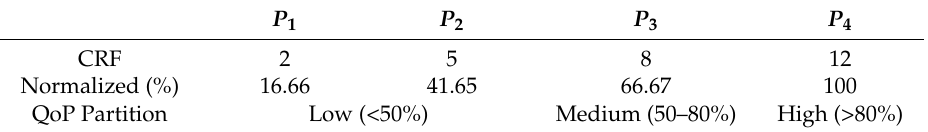
Table 10. QoP partition based on Cumulative Reward Function